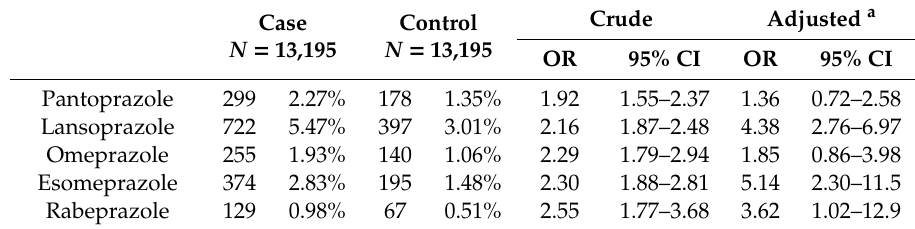
Table 3. Hepatic encephalopathy risk associated with di ff erent proton pump inhibitors for a 14-day window period.